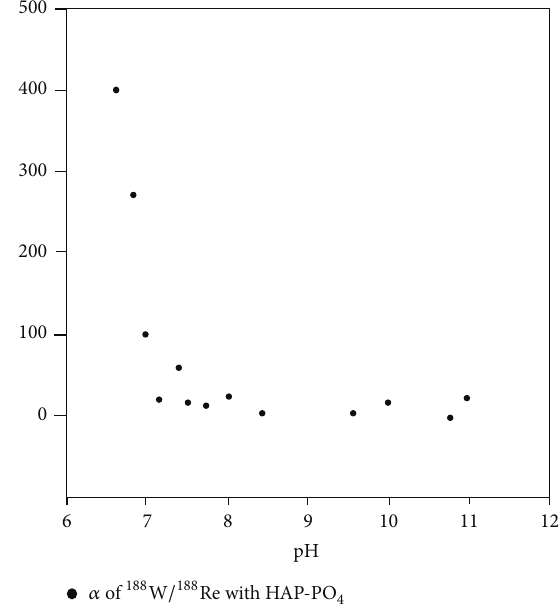
Figure 5: Separation factors of tungsten and rhenium ( 𝛼 hydroxyapatite